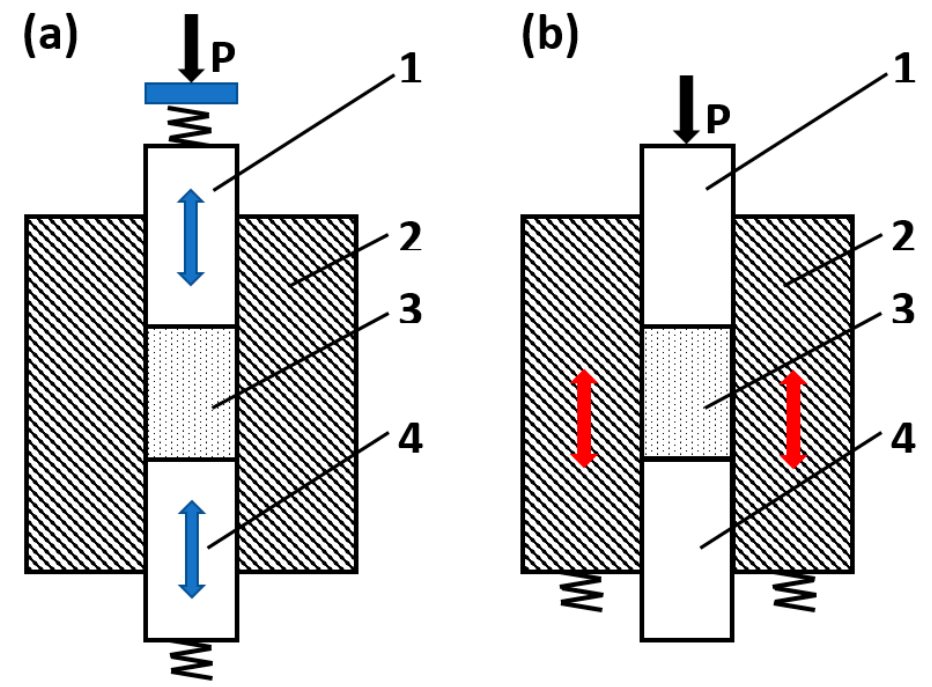
Figure 5. Schematics of vibration compaction. ( a ) The vibration is applied to both upper and bottom punches; ( b ) the vibration is applied to the matrix: 1—uper punch, 2—matrix, 3—molding mass, 4—bottom punch.